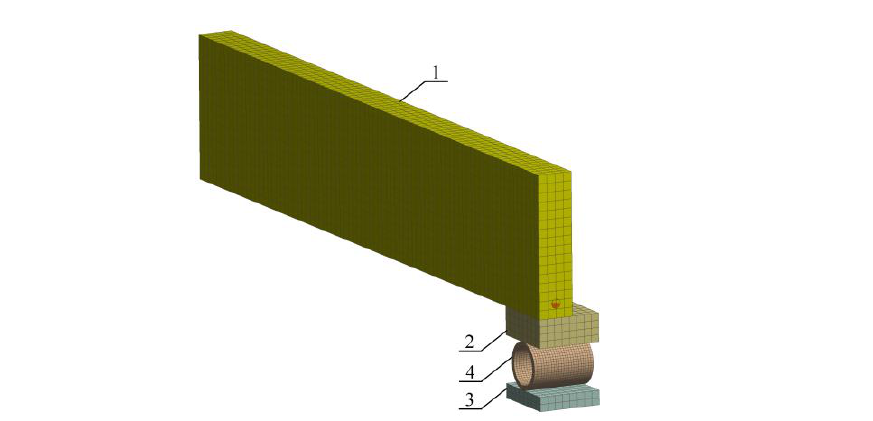
Fig. 1. General view of the FE model: 1 – reinforced concrete sample; 2 – moveable support plate; 3 – immoveable loading support plate; 4 – yielding support For this reason the rest three quarters of the model were replaced by horizontal perpendicular symmetry planes (Fig. 2) describing the reverse behavior of the sample parts.